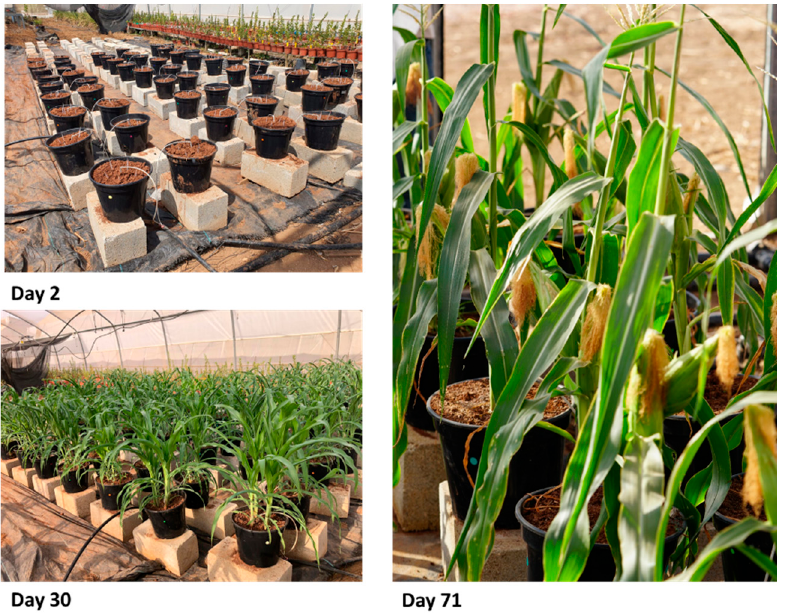
Figure 2. The 2020 experiment photo. The study was performed in 10–12 replications of six treatments in pots in a greenhouse throughout a full maize growing season and examined the effect of pre-growth of winter crops (clover or wheat) and maintaining soil integrity (by avoiding tillage) on late wilt disease. Commercial field soil after the winter growing season of clover and wheat and soil after the winter without early winter growing were used. The soils were divided, and simulation of conventional tillage or no-tillage was applied before moving the field soil to 10 L pots. The soils were inoculated with M. maydis, the late wilt disease causal agent, and sown with the susceptible maize hybrid Prelude cv.